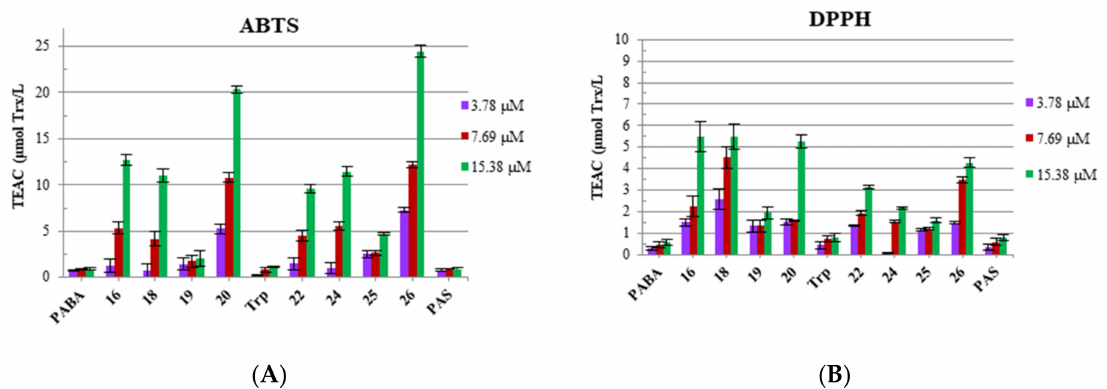
Figure 5. Antioxidant potential expressed as Trolox Equivalent Activity (TEAC) of (+)6 or (+)10-charged 16 , 18 , 20 , 22 , 24 , and 26 bola dendrimers and their neutral precursors 19 and 25 at three concentrations (3.78, 7.69, and 15.38 µ M) measured as neutral radicals scavenging ability (DPPH) ( B ) or cationic radicals scavenging ability (ABTS) ( A ) in relation to the known concentrations of Trolox. For comparison data for p -aminobenzoic acid (PABA), p -aminobenzenesulfonic acid (PAS) and tryptophane (Trp) are given.